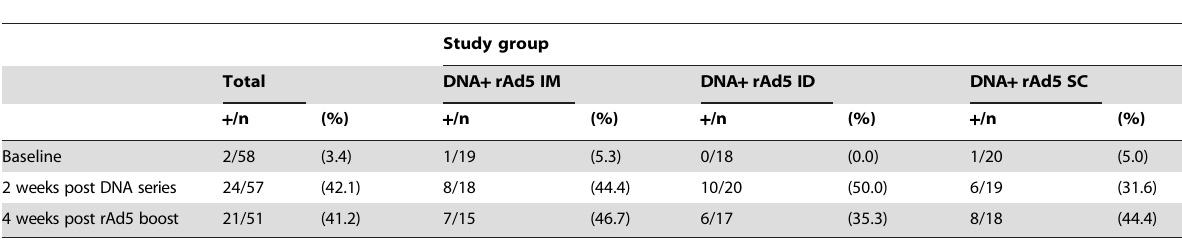
Table 3. ELISpot response rates to any HIV peptide by study visit and study group.